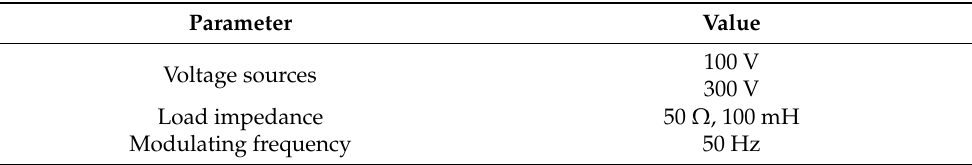
Table 3. Simulation